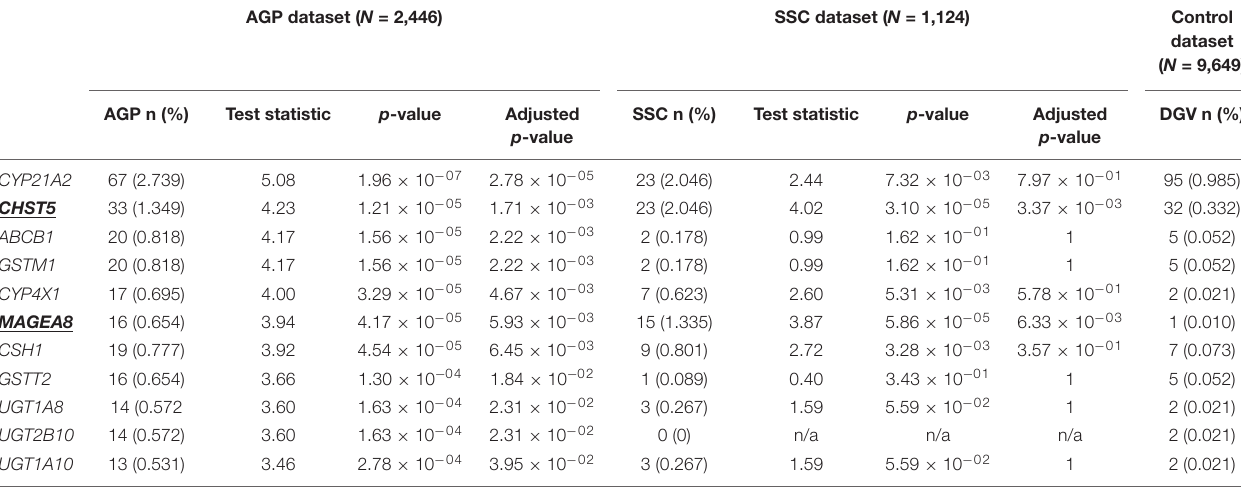
TABLE 3 | Summary statistics for the XenoReg genes with a higher proportion of CNVs in individuals with ASD from AGP and/or SSC datasets when compared to controls from the DGV